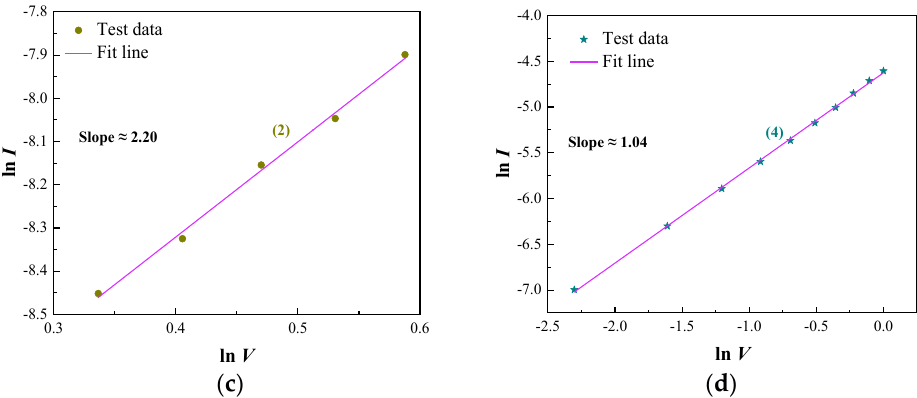
Figure 7. The measured and fitted I - V characteristic curves of the FTO/CsPbBr 3 /Al device. ( a ) Double logarithmic I - V curve of forward scanning voltage. ( b ) Measured and fitted line of I - V characteristic in 0–1.3 V. ( c ) Measured and fitted line of I - V characteristic in 1.4–1.8 V. ( d ) Measured and fitted line of I - V characteristic at a LRS.